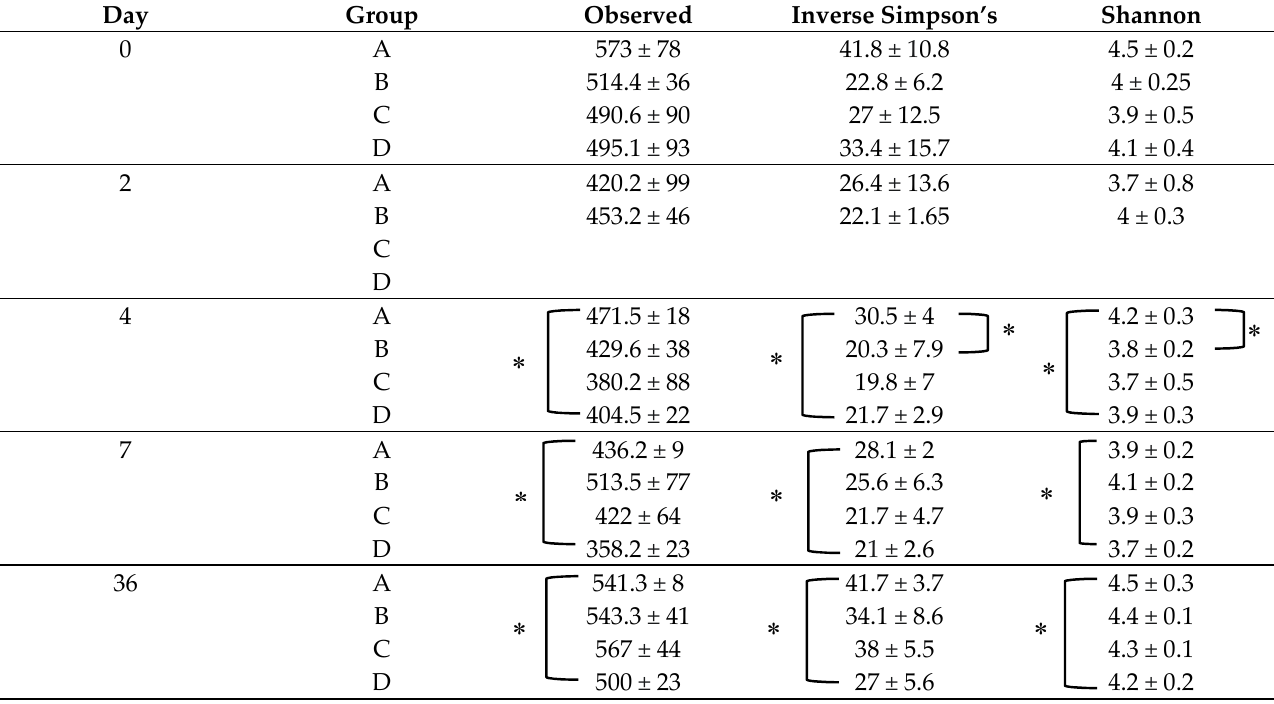
Table 1. Fecal microbiota alpha diversity indices of the four piglet groups across the five sampling time points. Day Group